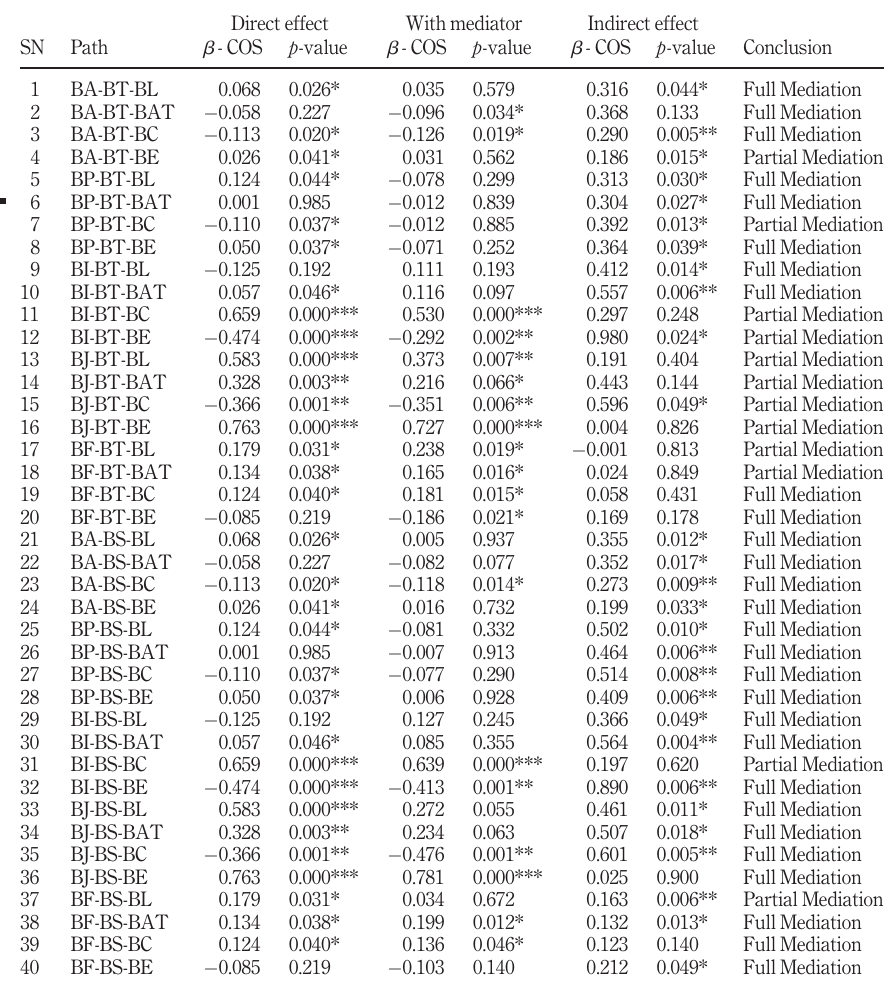
analysis of brand trust and